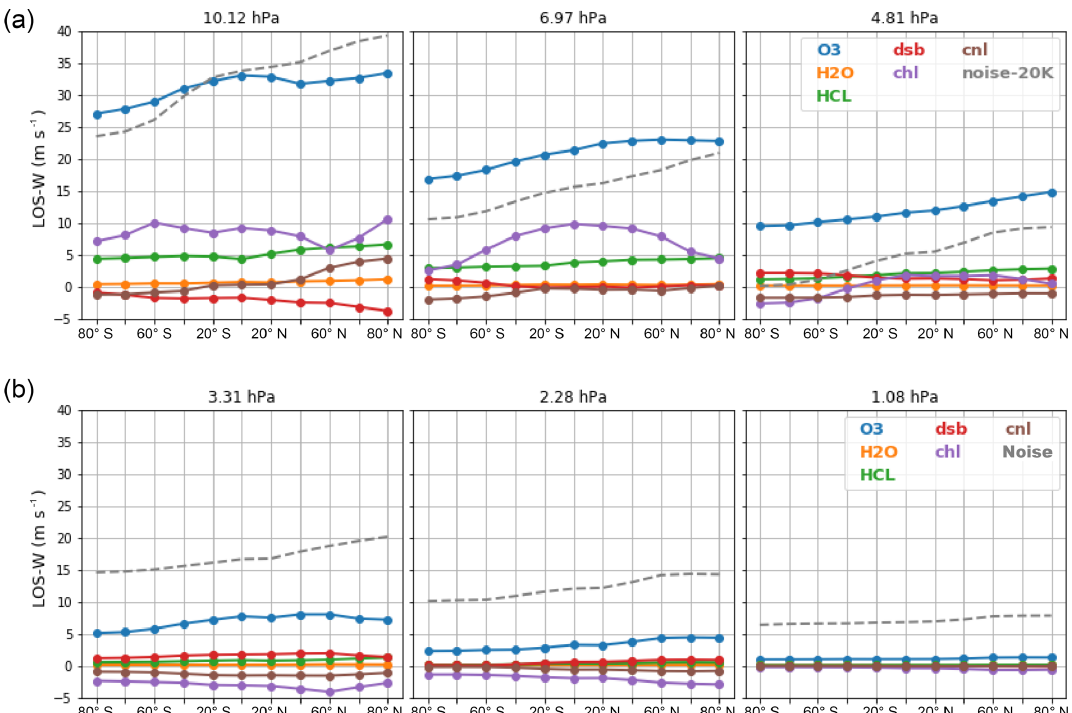
Figure 12. Line-of-sight wind retrieval biases with respect to latitudes near 10, 7 and 5hPa (a) , and near 3, 2 and 1hPa (b) . Biases are shown for the uncertainties in the spectroscopic parameters of O 3 , HCl, and H 2 O, the double-sideband ratio, the calibration hot load and the calibration